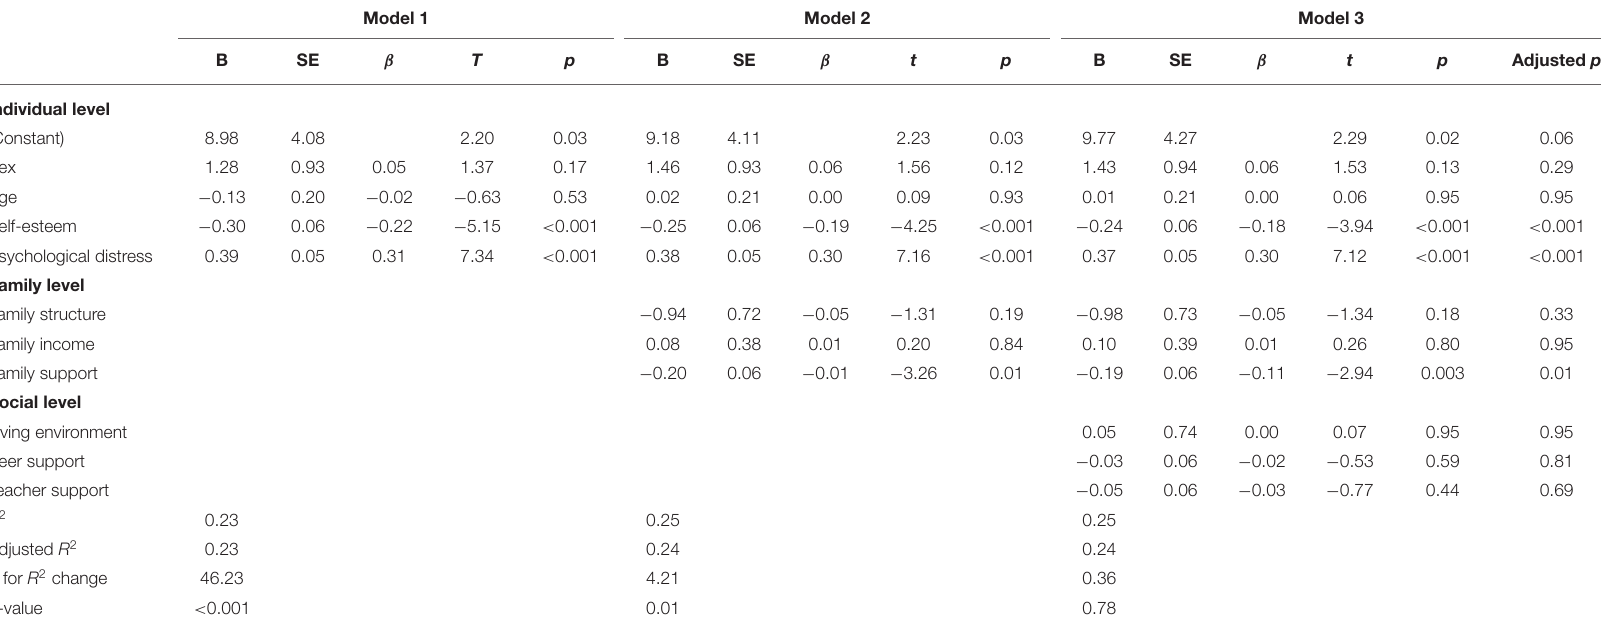
TABLE 2 | Hierarchical regression analyses of associator factors of NSSI behaviors ( N =